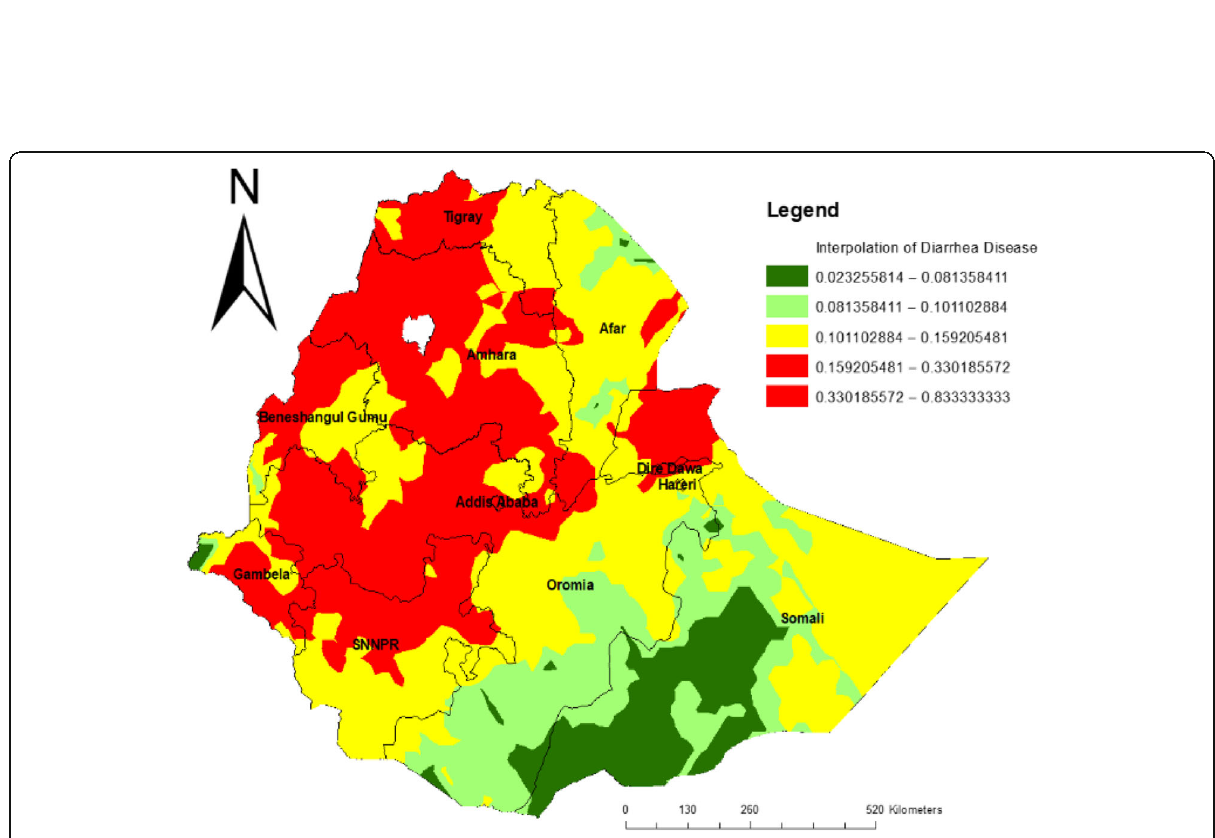
Fig. 4 Spatial interpolation of childhood diarrhea disease among under-five age in Ethiopia, EDHS 2016